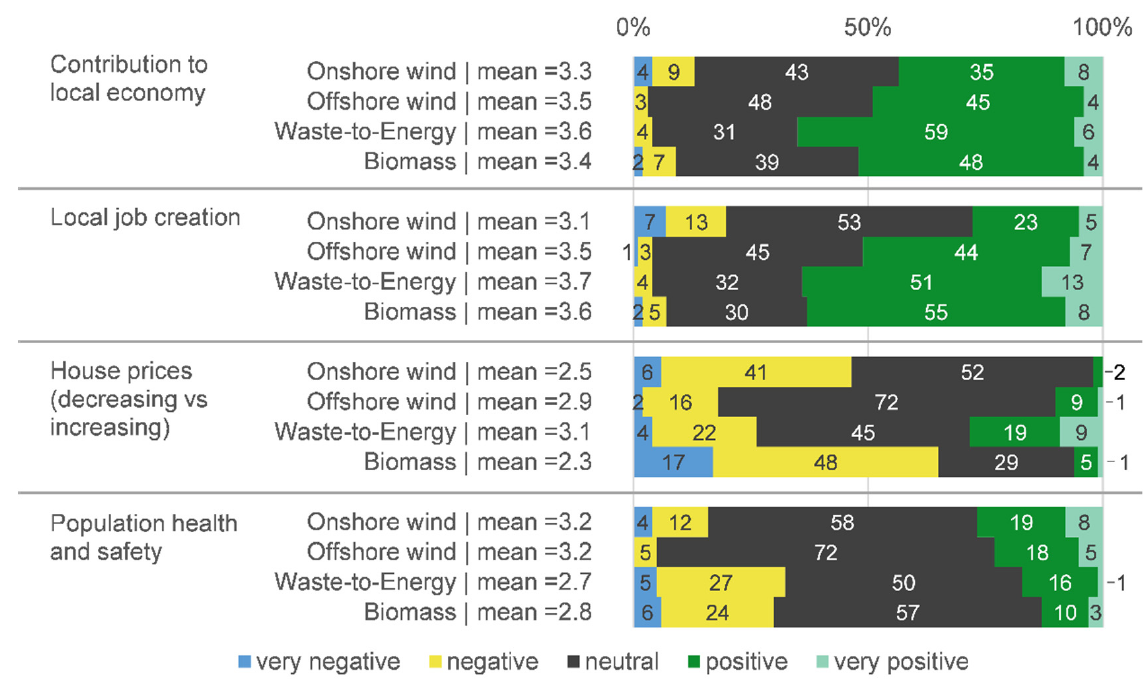
Figure 3. Experienced impact on the local economy and health in the energy neighborhoods in % per survey group. For the calculation of the mean value, a scale from 1: very negative to 5: very positive was used.